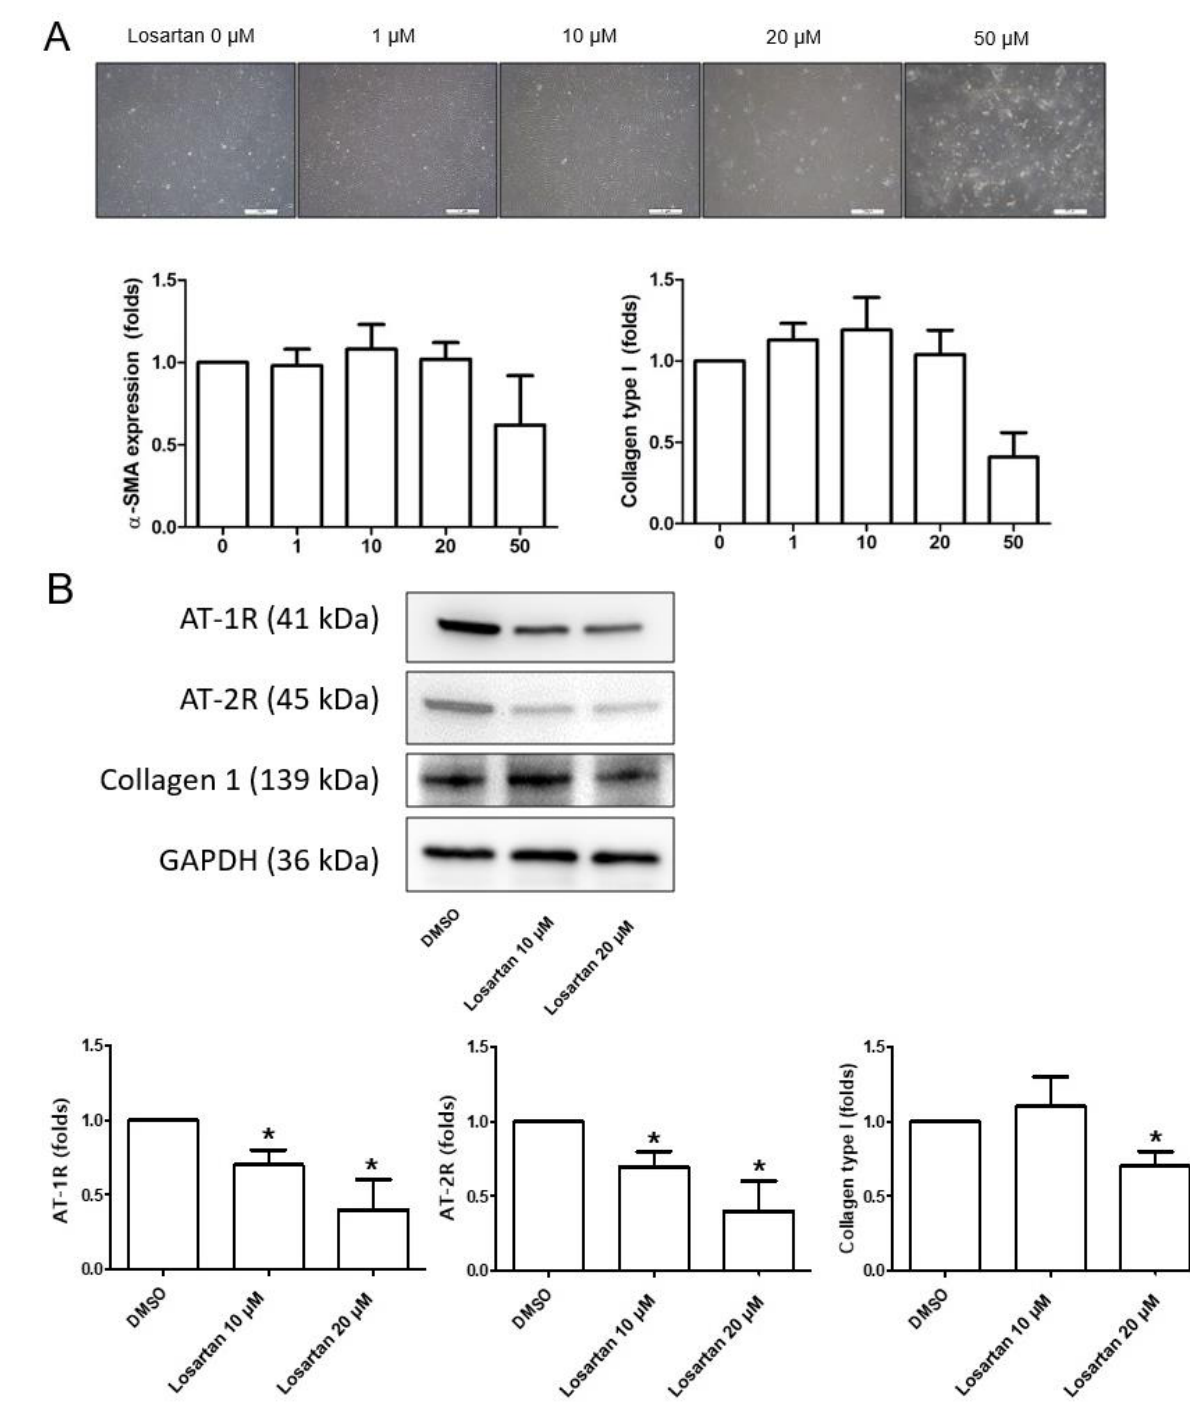
Figure 4. ( A ) Losartan 0~50 µ M was applied in a dose-dependent manner to scleral fibroblasts and toxicity started to occur at a concentration of 50 µ M in vitro. ( B ) Western blotting of Ang II receptors and collagen type I in the cultured scleral fibroblasts from systemic hypotensive rats. Losartan (10 or 20 µ M) was added to cultured scleral fibroblasts. The expression levels of AT-1R, AT-2R, and collagen type I were downregulated in the scleral fibroblasts after applying losartan. We selected Losartan 20 µ M from these data for further experiments. Scale bar = 500 µ m. The bar represents mean ± SD. Student’s t -test was used for the statistical evaluation. * p < 0.05 compared to the